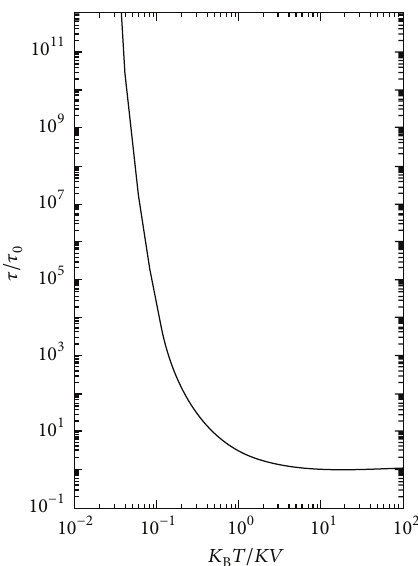
Figure 8: The variation of relaxation time as a function of thermal energy to anisotropy energy ratio values.